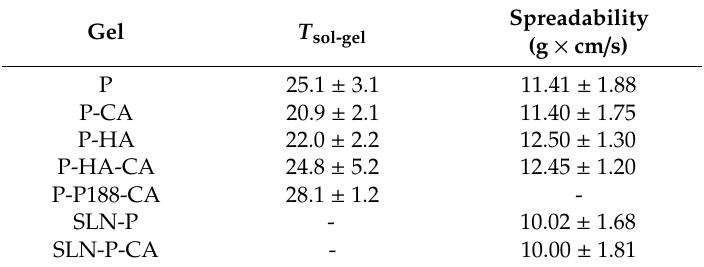
Table 5. T sol-gel and spreadability parameters of the indicated gels.